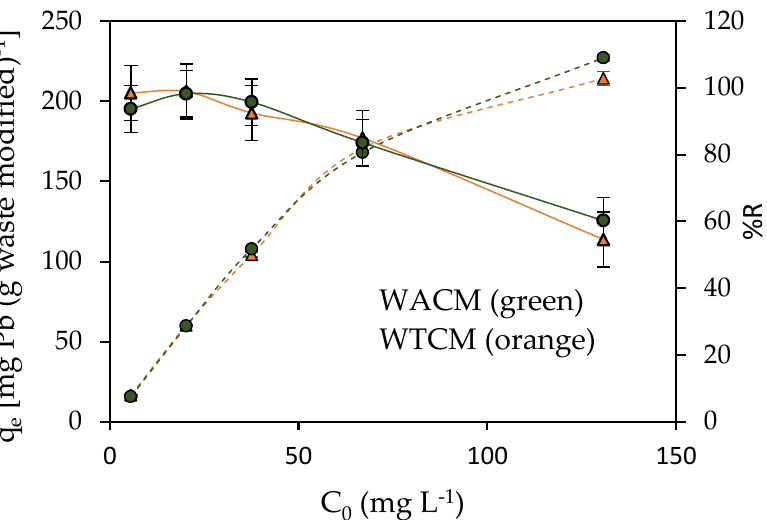
Figure 7. Effect of the initial Pb(II) concentration C 0 on q e (dotted lines) and %R (full lines). t = 60 min, T = 293 K, pH 4, biosorbent dose = 2 g L −1 .